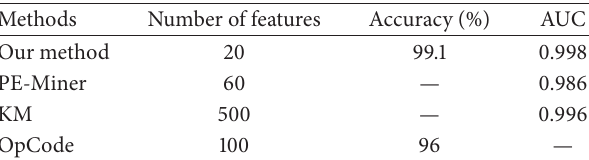
Table 7: Comparisons with the related static